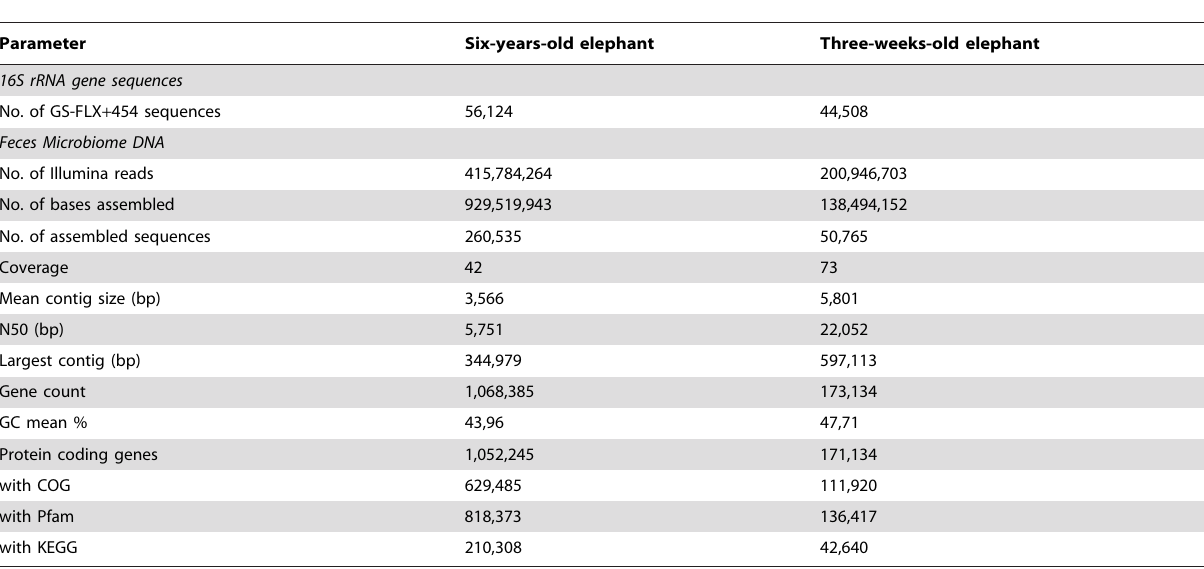
Table 1. Overall numbers of sequences and contigs generated for the two elephant feces samples.